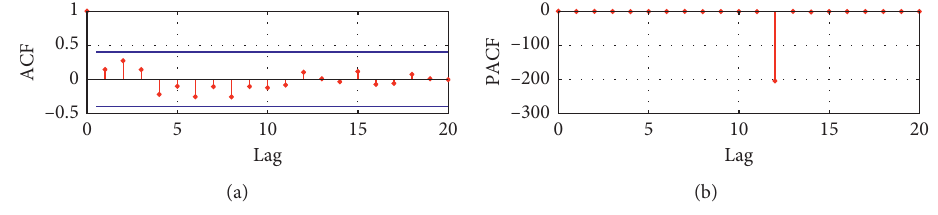
Figure 12: ARIMA (1,0,0) ACF and PACF.